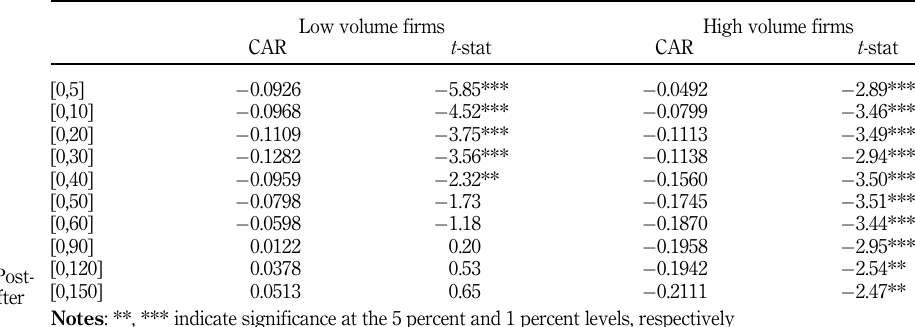
Table VII. Robustness test - The gross and net effects